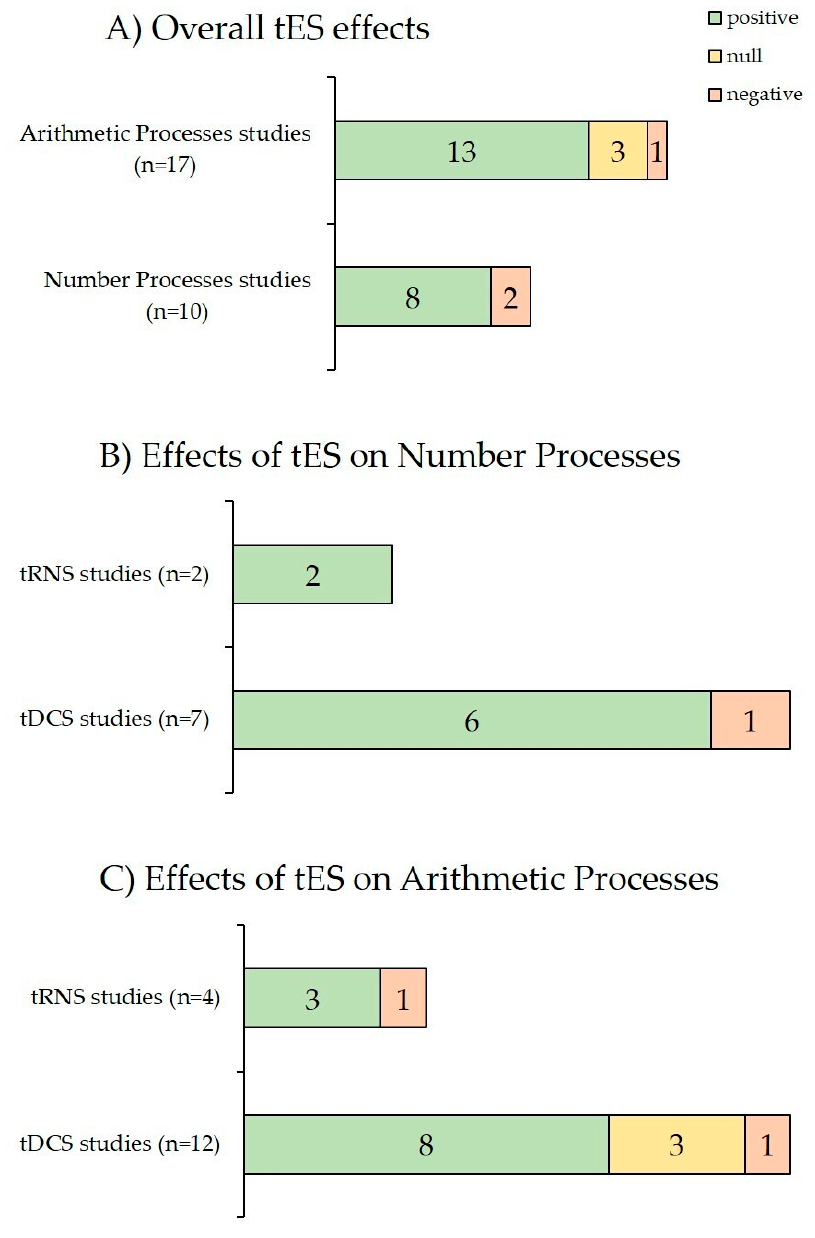
Figure 4. Summary of tES effects. Panel ( A ) shows the tES effects across all reviewed studies based on non-symbolic and symbolic number processes and arithmetic processes. Panel ( B ) shows the comparisons between tDCS and tRNS effects across all studies addressing non-symbolic and symbolic number processes. Panel ( C ) shows the comparisons between tDCS and tRNS effects across all studies addressing arithmetic processes. The effects of HD-tDCS were included in the tDCS effects. The effects of tACS were also not considered since only one study was found. Legend: tES = transcranial electrical stimulation; tDCS = transcranial direct current stimulation, tRNS = transcranial random noise stimulation.